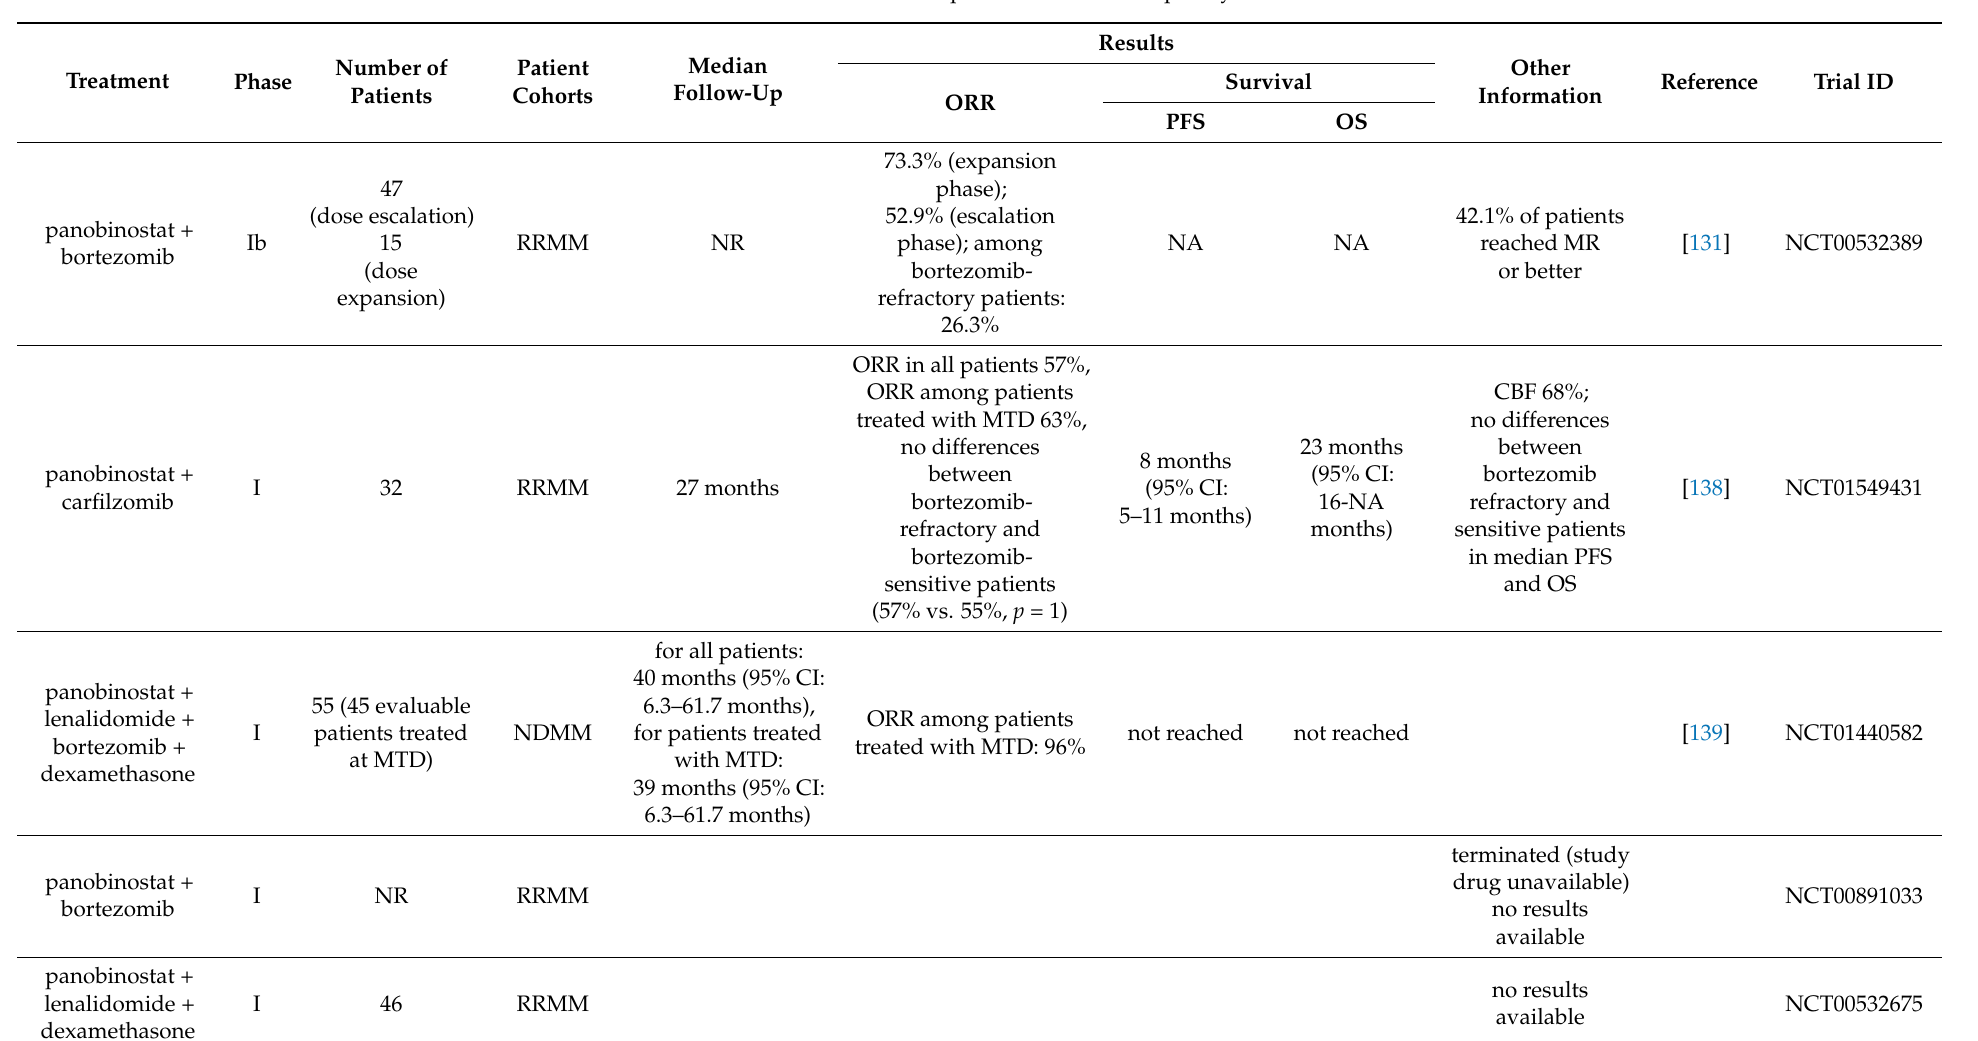
Table 1. The main trials with panobinostat in multiple